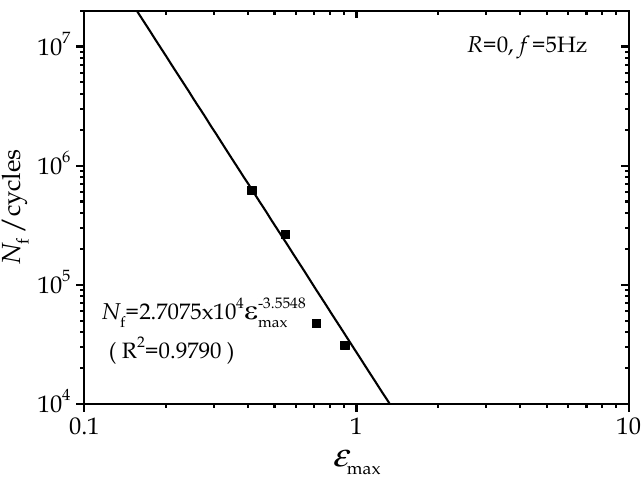
Figure 7. S–N curve of the hourglass rubber specimen.